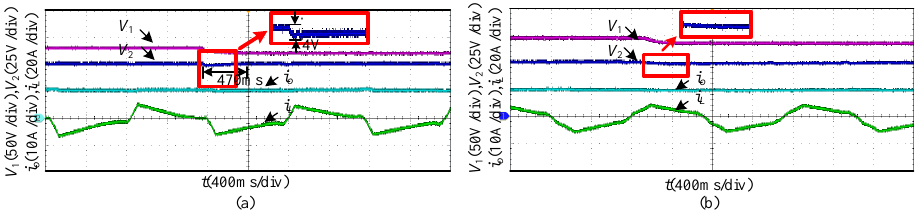
Figure 9. Transient waveform of different control strategies when the input voltage steps change: ( a ) the traditional voltage closed-loop control strategy based on SPS control, ( b ) the MUOC strategy. In the case where the input voltage V 1 = 130 V, the output voltage V 2 = 50 V, and the load R was set as 5 Ω and 3.79 Ω , Figure 10a,b show the experimental waveforms of input voltage, output voltage, output current, and inductance current of the DAB converter under the traditional voltage closed-loop control strategy based on SPS control under the load steps change. As can be seen from Figure 10, the output voltage dropped by about 10 V (20%) and was stable again after about 320 ms when the load was decreased; the output voltage suddenly increased by about 13 V (26%), and the system was also stable after about 320 ms when the load was increased.